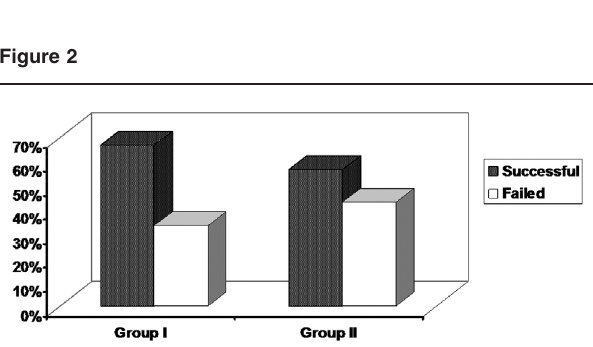
Estimated outcomes of BiPAP therapy in both study groups. The numberofsuccessfulcaseswas20(66.7%)ingroupIand17(56.7%) in group II ( P